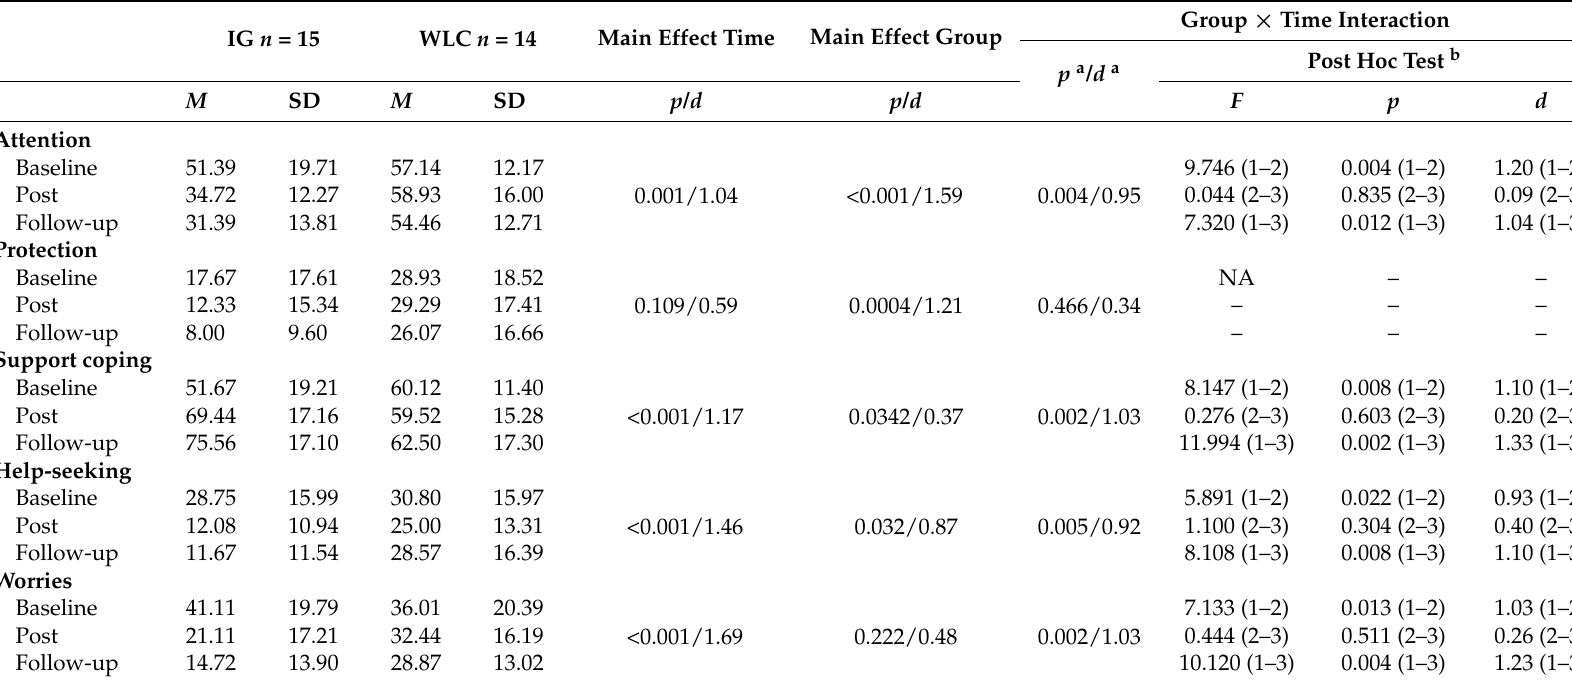
Table 3. Mothers’ pain-related behavior and worries (means, SDs ) with results of repeated measures ANOVA (main effects for group, time, and group × time interaction).